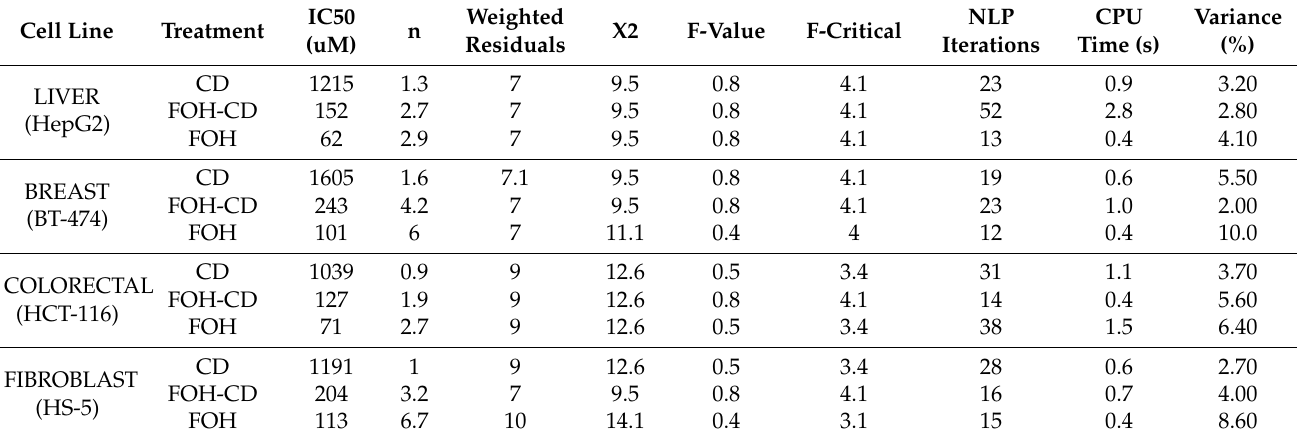
Table 1. Parameter estimation for fitting the data to dose-response